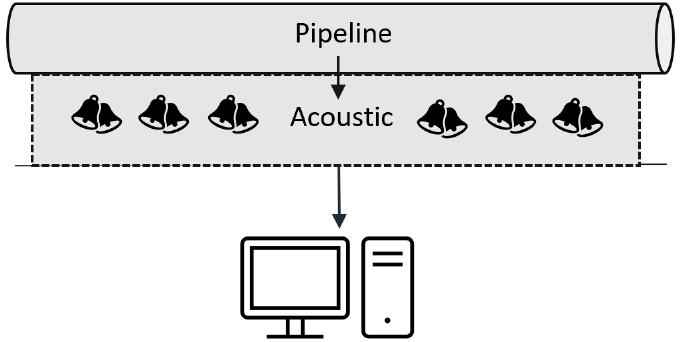
Figure 3. Illustration of Acoustic Emission Technique located all along in the monitoring pipeline